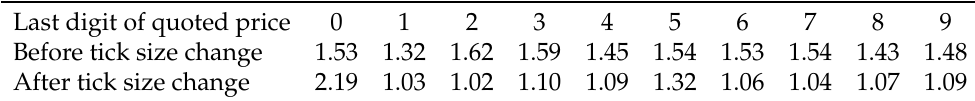
Table 3. Size of Average Order (Million) at the Best Ask. Last digit of quoted